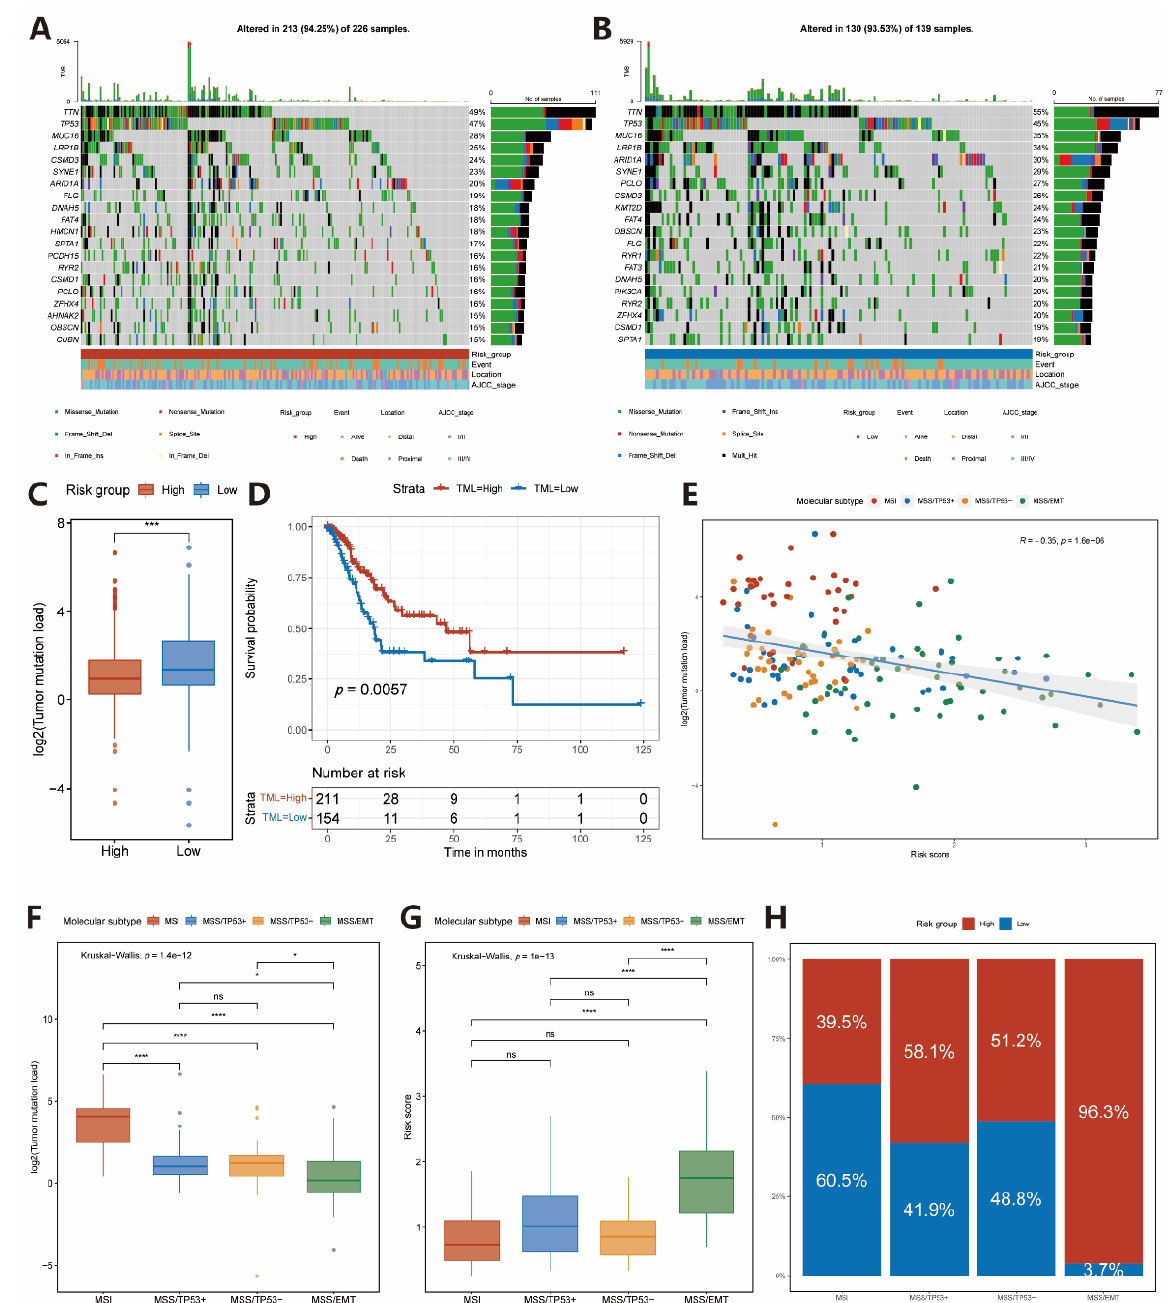
Figure 4. Comparison of tumor mutations between high- and low-risk groups. ( A , B ) The oncoPrint of high- and low-risk groups in the TCGA-STAD cohort. ( C ) TML difference in the high- and low-risk groups. Wilcoxon test, *** p < 0.001. ( D ) Kaplan–Meier curves for high- and low-TML groups of the TCGA-STAD cohort. Log-rank test, p = 0.011. ( E ) The relationship between risk score and TML in TCGA-STAD cohort (Spearman test, p < 0.0001). The dotted color indicates the ACRG molecular subtypes of GC. ( F ) TML difference in different ACRG molecular subtypes of the TCGA-STAD cohort. Steel–Dwass test, * p < 0.05; *** p < 0.001; ns, not statistically significant. ( G , H ) Distribution of the risk score and percentage of the high-risk group in different ACRG molecular subtypes of the TCGA-STAD cohort. Steel–Dwass test, **** p < 0.0001; ns, not statistically